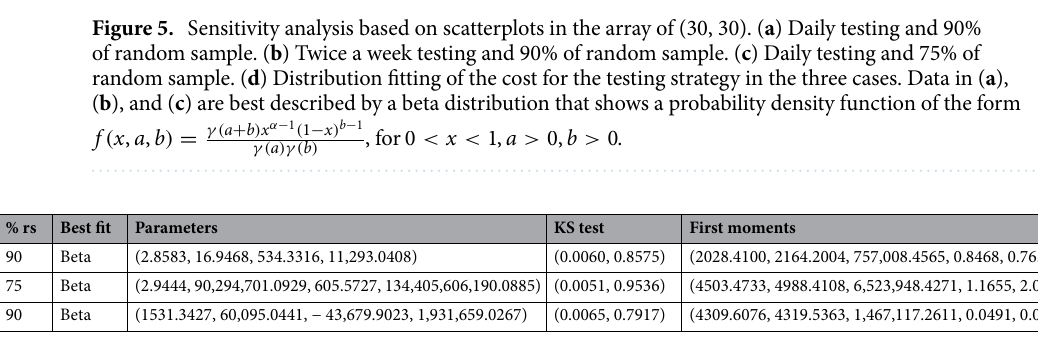
Table 2. Statistics of testing-isolated strategies in the array of (30, 30). Percentage of random sample (% rs). Estimated parameters (a, b, loc, scale). KS goodness-of-fit test (D, p-value). First moments (median, mean, variance, skewness,